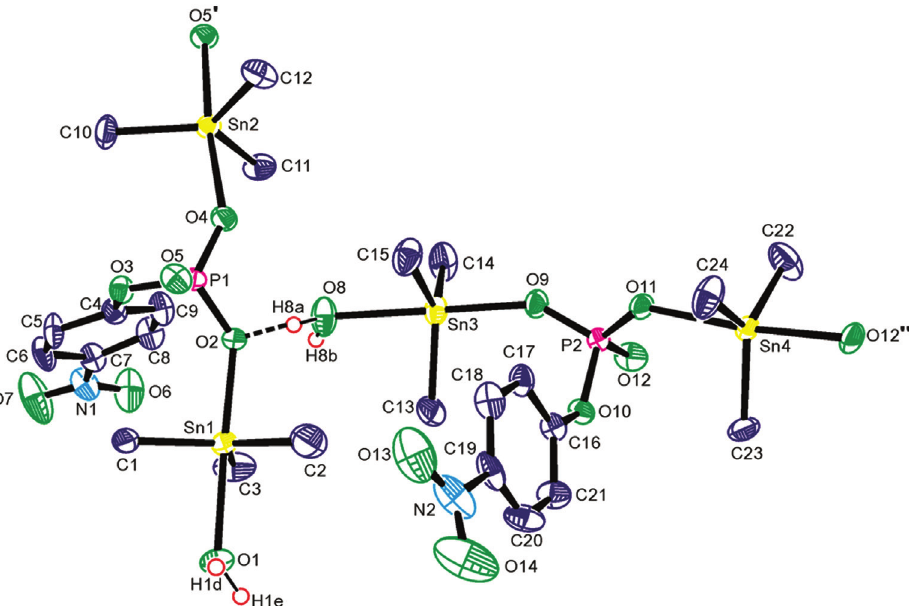
Figure 1 The asymmetric unit of 1 showing the labeling scheme (ortep view). Displacement ellipsoids are drawn at 50% probability level [H atoms non-implicating in hydrogen bonding were omitted for clarity. Color code: Sn, yellow; C, violet; O, green; P, pink; N, light blue]. Selected bond lengths and angles (Å, ° ): Sn1-C2 2.092(9), Sn1-C1 2.097(7), Sn1-C3 2.110(7), Sn1-O2 2.174(4), Sn1-O1 2.391(5), Sn2-C11 2.120(7), Sn2-C10 2.121(7), Sn2-C12 2.129(7), Sn2-O5 2.231(4), Sn2-O4 2.239(4), Sn3-C14 2.119(8), Sn3-C15 2.119(8), Sn3-C13 2.134(8), Sn3-O9 2.136(5), Sn3-O8 2.401(6), Sn4-C23 2.105(8), Sn4-C24 2.109(8), Sn4-C22 2.113(8), Sn4-O12 ii